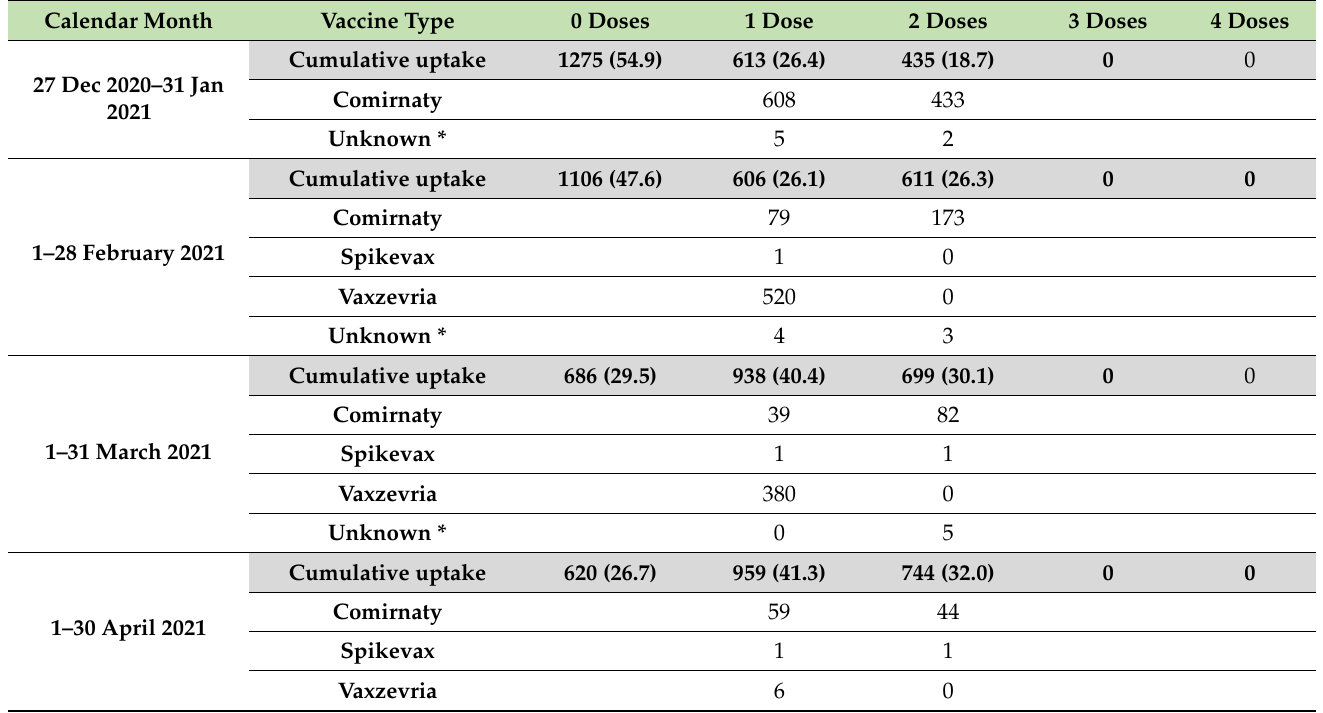
Table 2. COVID-19 vaccination uptake among workers of the University of Trieste. Number (N) and row percentage